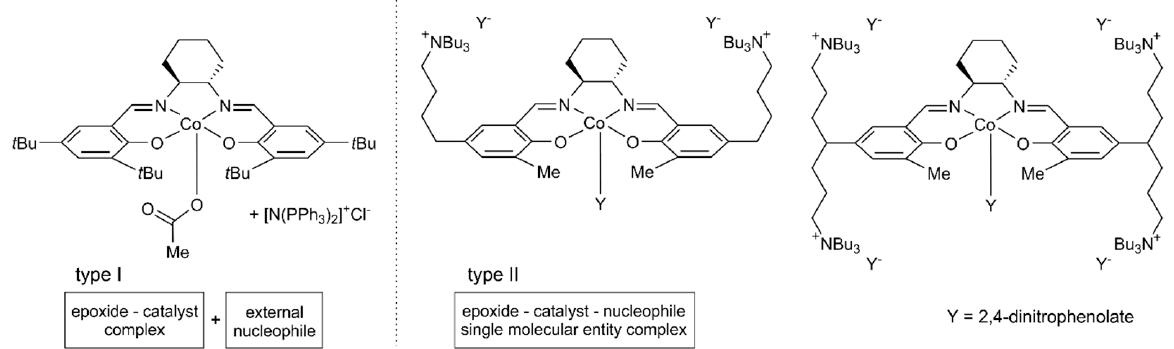
Figure 1. Example catalytic systems for CO 2 /epoxides copolymerization processes based on Co(III)-salcy complexes.